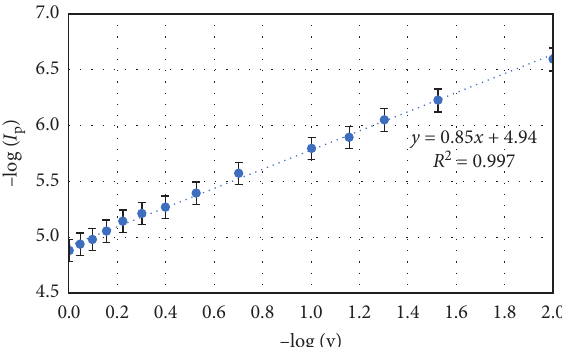
Figure 3: Cyclic voltammetry current (log I 0.1mg L − 1 mercury, deposition potential − 0.5V, deposition time 30s, and scan rate from 10mV s − 1 to 1000mVs − 1 .